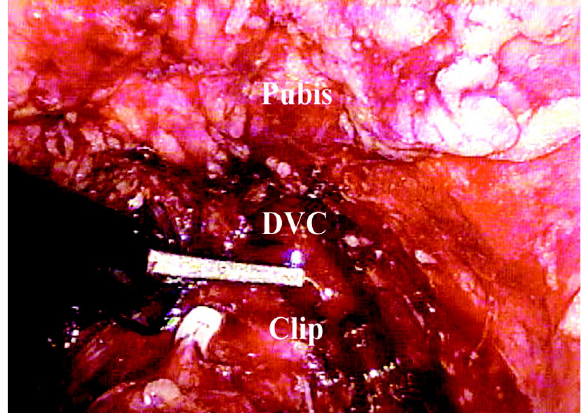
Figure 5 – Sectioning of dorsal vein complex with harmonic scalpel. Ligation of dorsal vein complex (DVC) with suture.